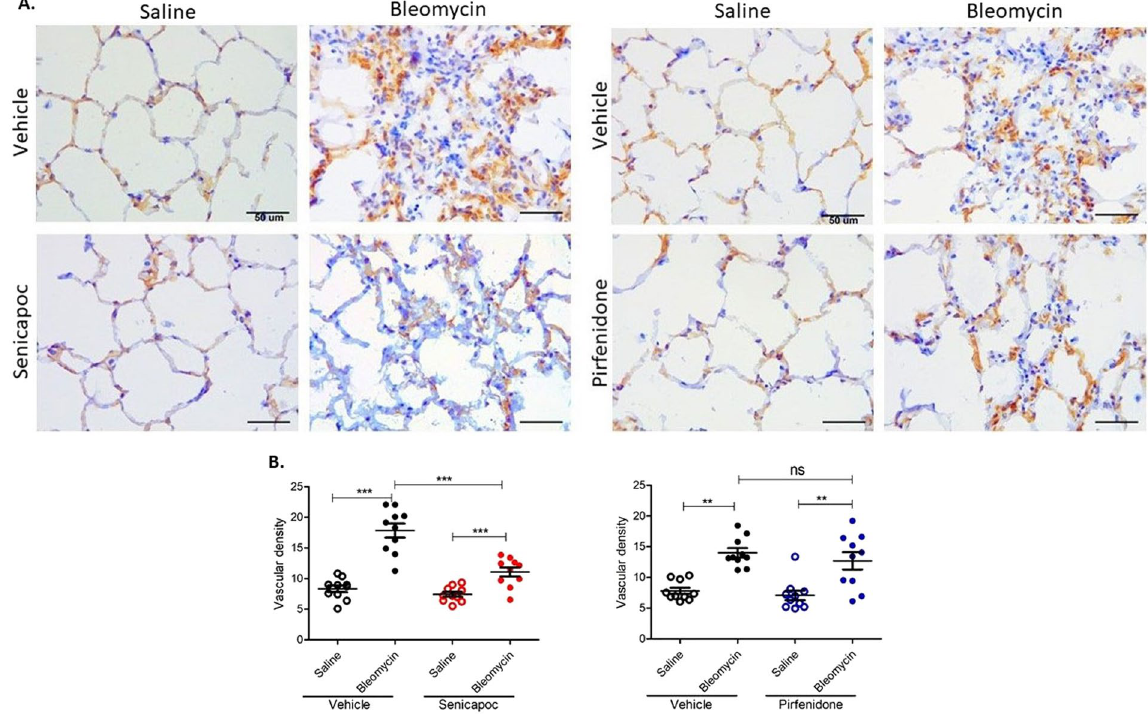
Figure 2. Effects of senicapoc and pirfenidone on remodelling of CD34 stained capillaries induced by bleomycin. ( A ) The panels show representative anti-CD34 immuno-stained sections of lung segments from sheep that were treated with either vehicle, senicapoc or pirfenidone. The lung segments from individual sheep were infused with either saline (left-side images), or bleomycin (right-side images). ( B ) Shows the vascular density data between the different treatment groups. Vascular density was determined by the percentage of the total area of CD34-positive vascular area per field of lung parenchyma. Ten images were taken from fibroproliferative areas for each lobe from each sheep (n = 10) and the values for each of the ten images were averaged for each lobe. Data show individual values plus mean. Significance was determined using a paired t test between lobes from the same treatment group, and an unpaired t test between lobes from different groups, ** p < 0.01, *** p < 0.001, ns-not significant. Data represent mean ( ± SEM). Scale bars = 50 µ